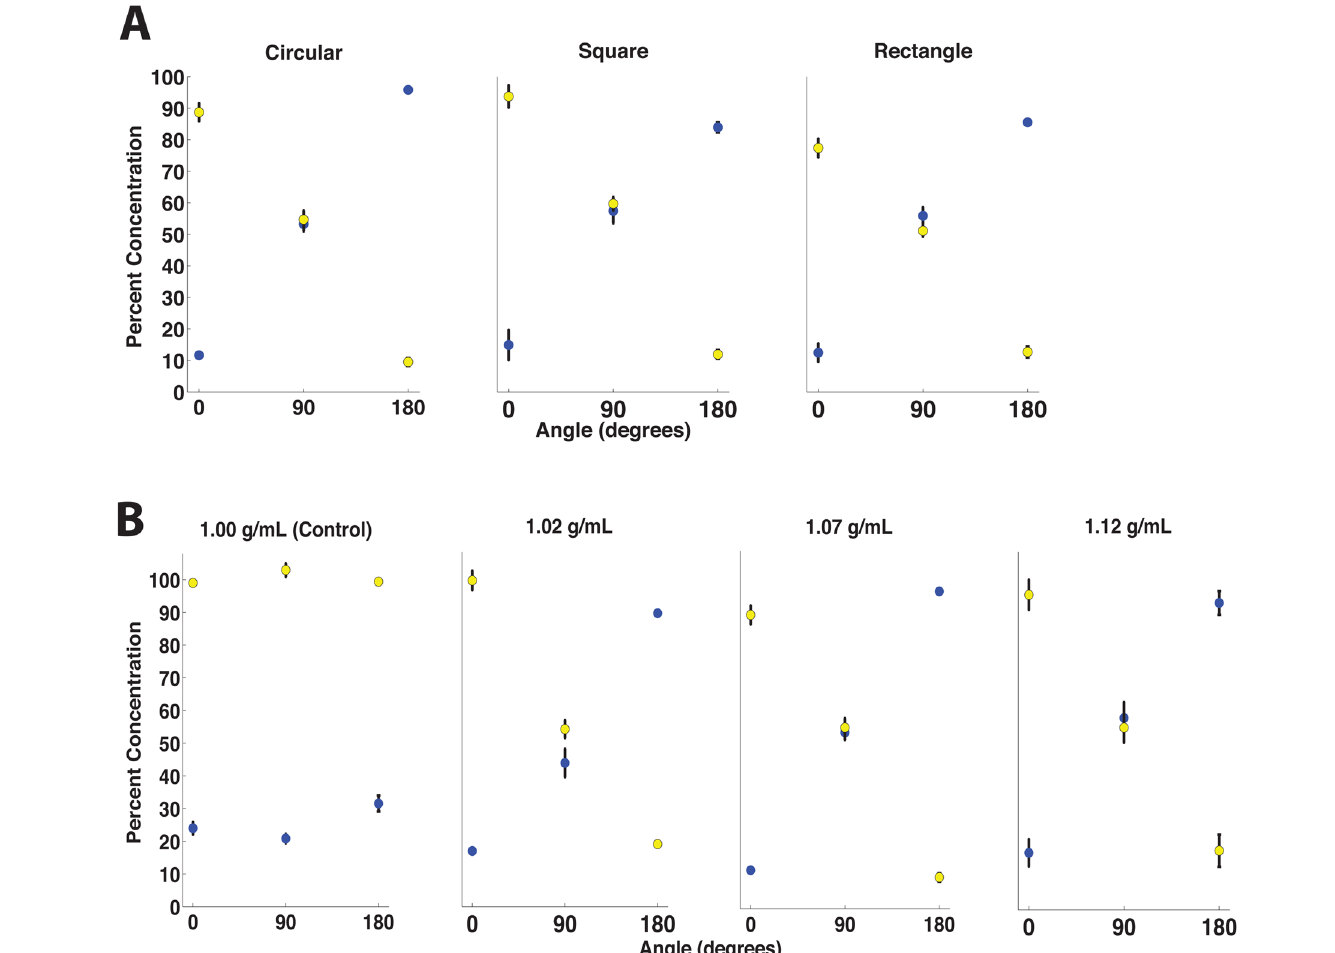
Fig 5. (A) Concentrations of yellow and blue dyes at Outlet 1 in mixer chips held at 0°, 90° and 180°, for chips with circular, square, and rectangular channel cross-sections. Chip orientation can be used to control on-chip fluids in devices with a variety of channel cross-sectional shapes, although performance deteriorates somewhat in the rectangular channel. These results suggest that microfluidic channels with aspect ratios close to one are best suited for orientation-based control. (B) Outlet fluid concentrations measured at Outlet 1 while orienting the mixer chip at 0°, 90° and 180° for four different fluid densities at Inlet 1. The density of fluid at Inlet 2 was kept constant at 1.00 g/mL. When there is no difference in fluid densities between the two inlet fluids, fluid reorientation is not observed and orientation-based control cannot be used (Control case). However, if the fluid density in Inlet 1 is just 2% greater than the fluid density in Inlet 2, then the flowing fluids reorient with respect to gravity and orientation-based control is